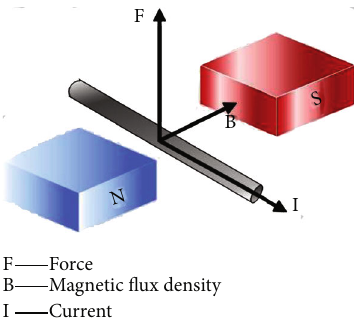
Figure 1: Schematic diagram of ampere